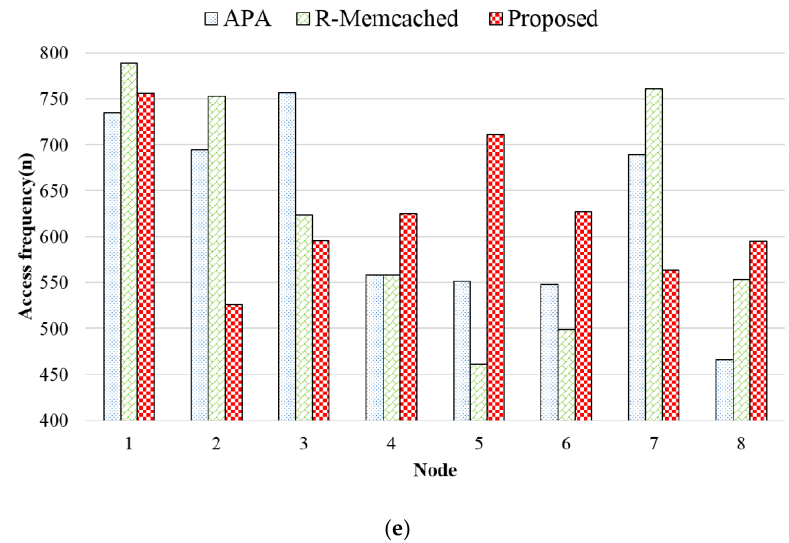
Figure 19. Node access frequency according to the number of query requests. ( a ) 1000 queries. ( b ) 2000 queries. ( c ) 3000 queries. ( d ) 4000 queries. ( e ) 5000 queries.